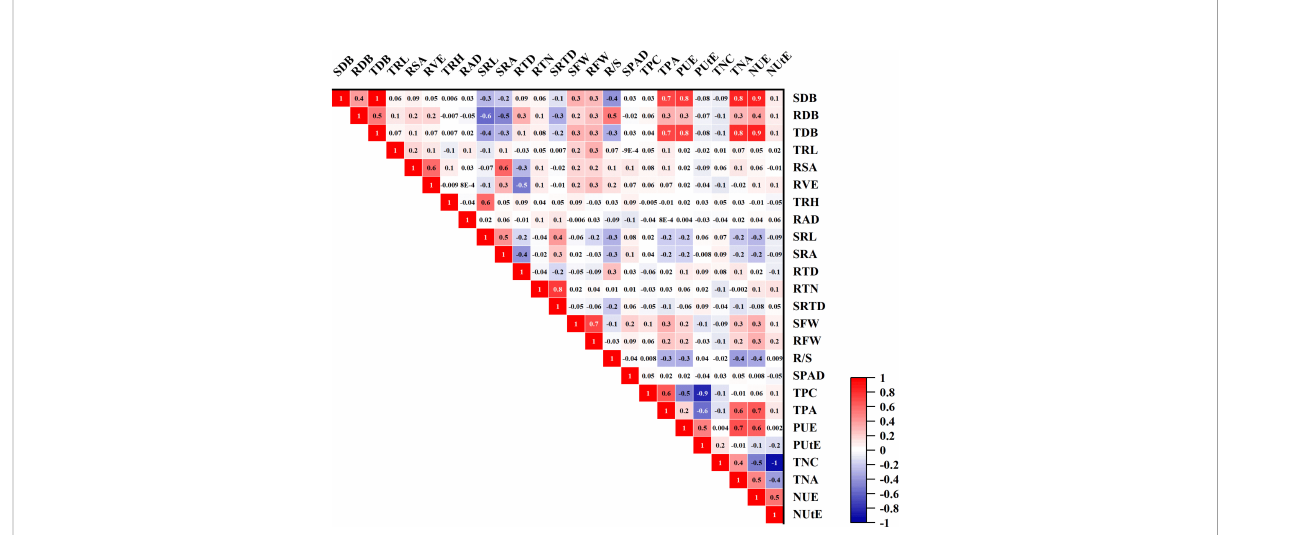
FIGURE 7 Pearson correlation study of 25 phenotypic traits in 384 Cotton Genotypes in relative values. The red box in the fi gure represents a positive correlation, the blue box represents a negative correlation, and the size of the number means the size of the correlation coef fi cient.